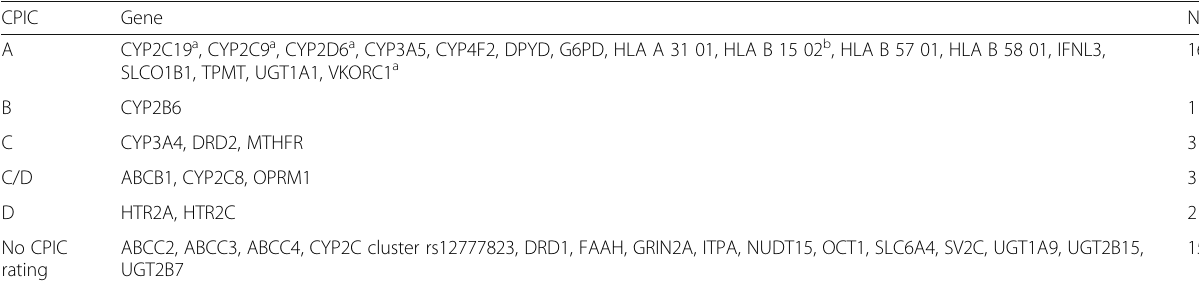
Table 1 Listing of the 40 genes identified by IGNITE member PIs and each gene ’ s CPIC Level of Evidence. Genes with Medicare/ Medicaid reimbursement are identified with a